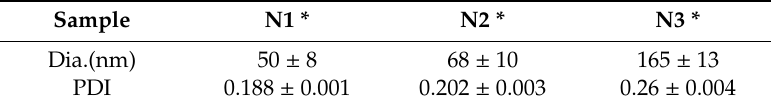
Table 1. Hydrodynamic diameter of emulsions.